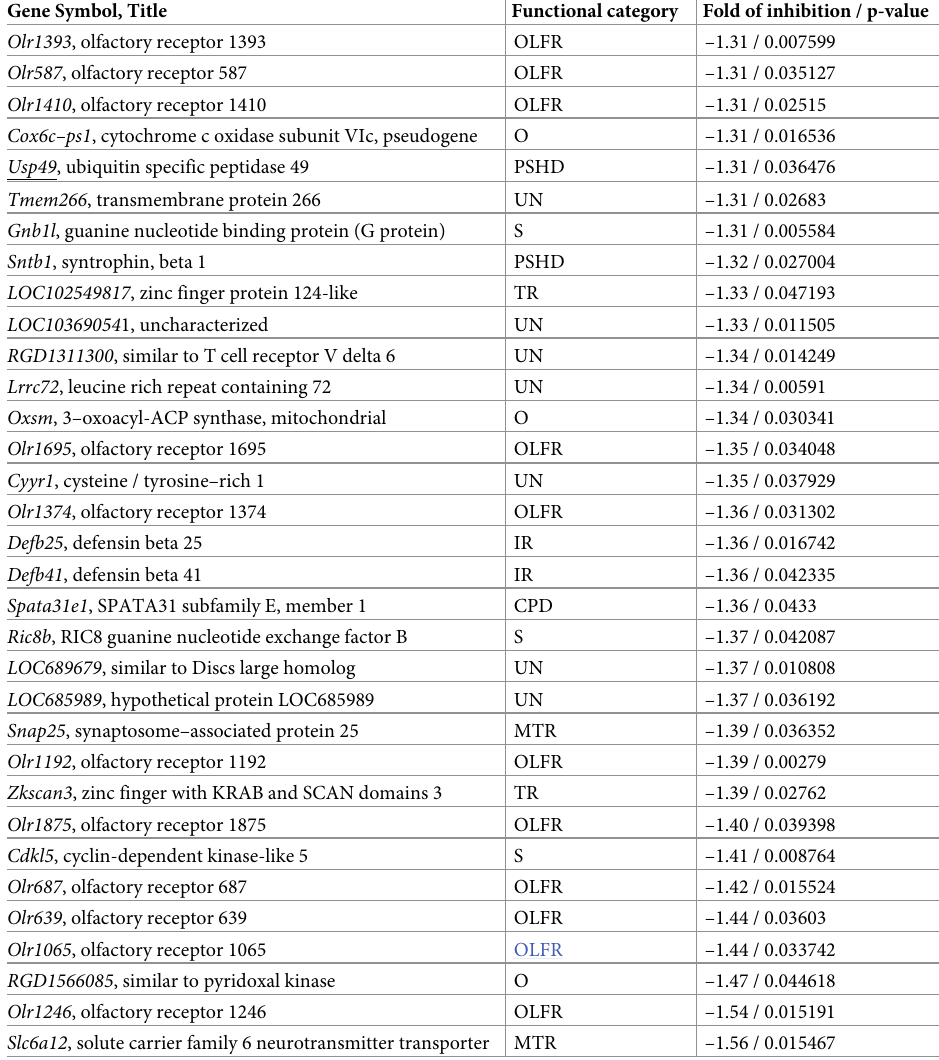
Table 5. Genes whose expression was decreased by 100 nM ouabain by more than 1.3-fold. Gene Symbol, Title